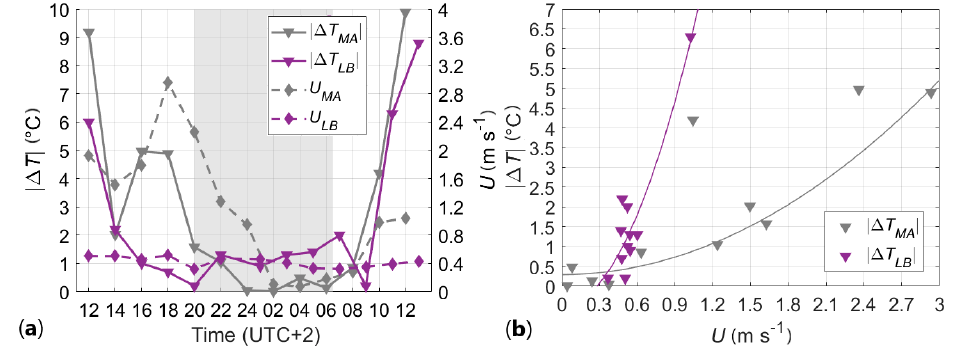
Figure 7. ( a ) Urban Heat Island (UHI) intensity from building façade temperature difference (solid lines) and in-canyon wind speed (dashed lines) evolution within the day of the summer intensive thermographic campaign in Bologna (22–23 August 2017). The shadowed region defines the nocturnal period between sunset (2000 UTC) and sunrise (0630 UTC). ( b ) UHI intensity from building façade temperature difference as a function of the in-canyon wind speed measured at the ground levels of each canyon. Table 3. Fit characteristics and likelihood parameters (coe ffi cient of determination R 2 and root mean square error (RMSE)) between data in Figure 7b and Equation (3) for the different cases. a [ ◦ C m − 2 s 2